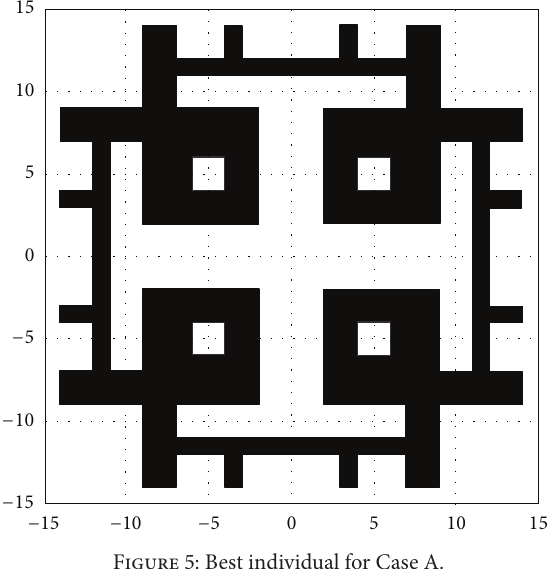
Figure 5: Best individual for Case A.